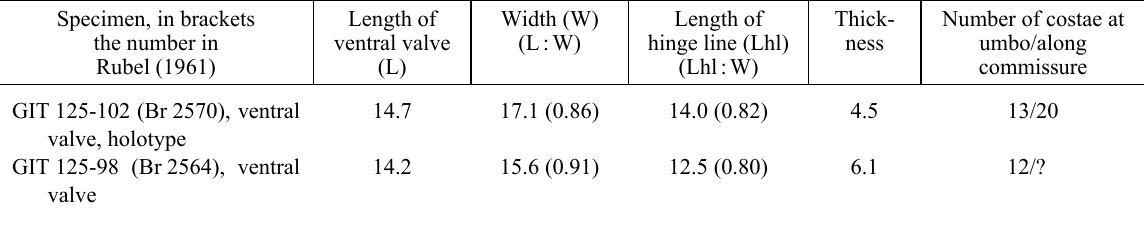
Table 2. Dimensions (in millimetres) of Rogorthis pakriensis (Rubel, 1961). Ratios of measurements in brackets Specimen, in brackets the number in Rubel (1961)